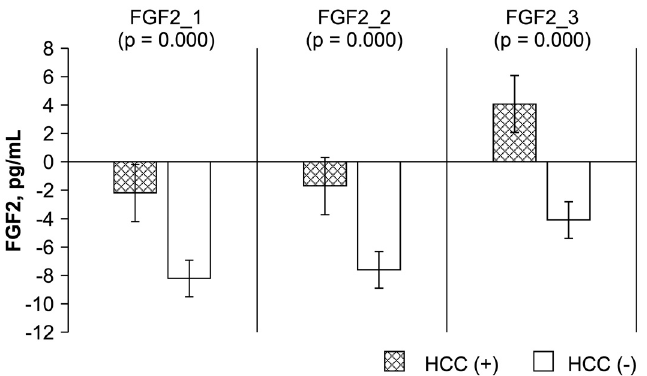
Fig 1. Statistical analysis of FGF-2, survivin, Ki67, endostatin, and VEGF levels, as measured by ELISA before (_1), early after (_2), and late after (_3) after living donor liver transplantation (LDLT). The Mann-Whitney U test was used to compare the differences in the biomarkers at the various time points between the recipients with and those without HCC recurrence.